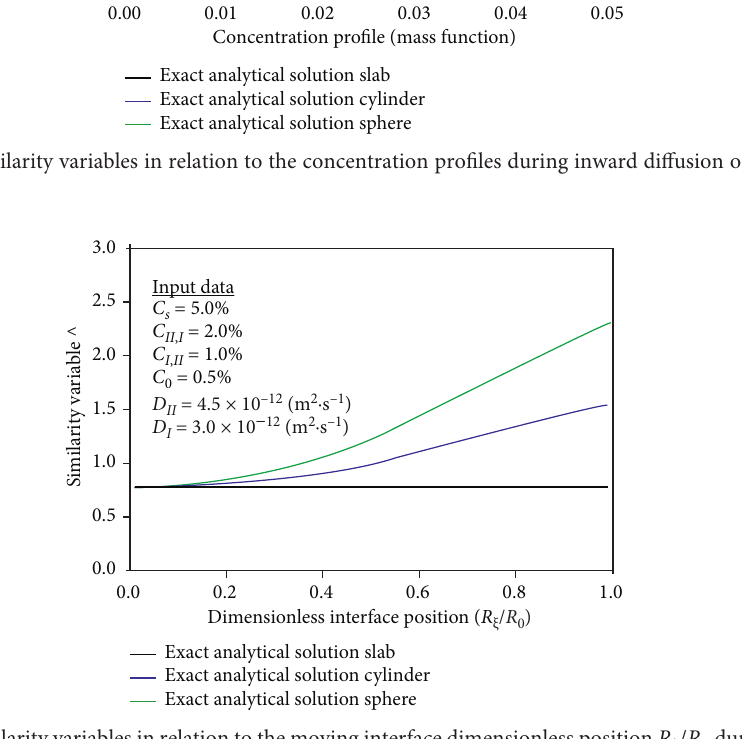
/ R during inward diffusion of a ξ 0